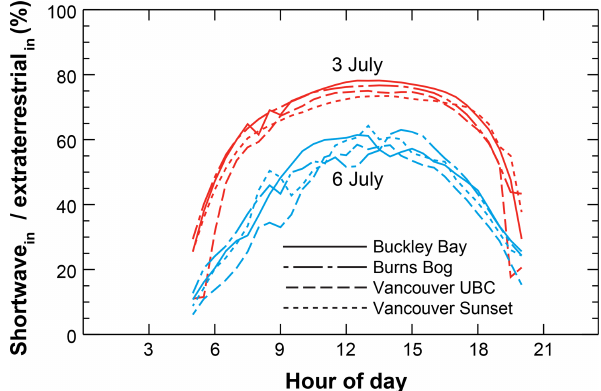
Figure 5. Diurnal impacts on incoming solar radiation at each site for 3 (cloudless day) and 6 (smoke)